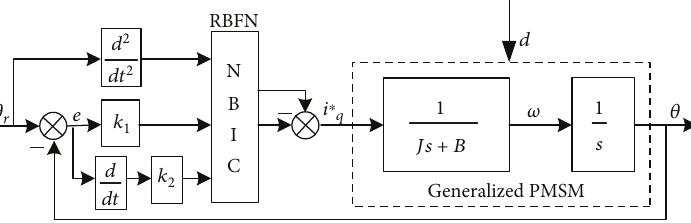
Figure 3: The PMSM position tracking control diagram based on the proposed NBIC. Table 1: